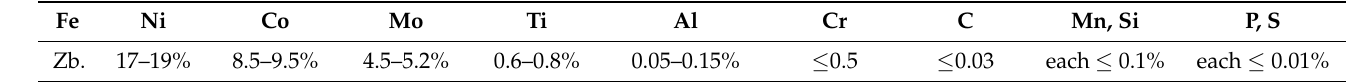
Table 2. Chemical composition of steel MS1 [52].